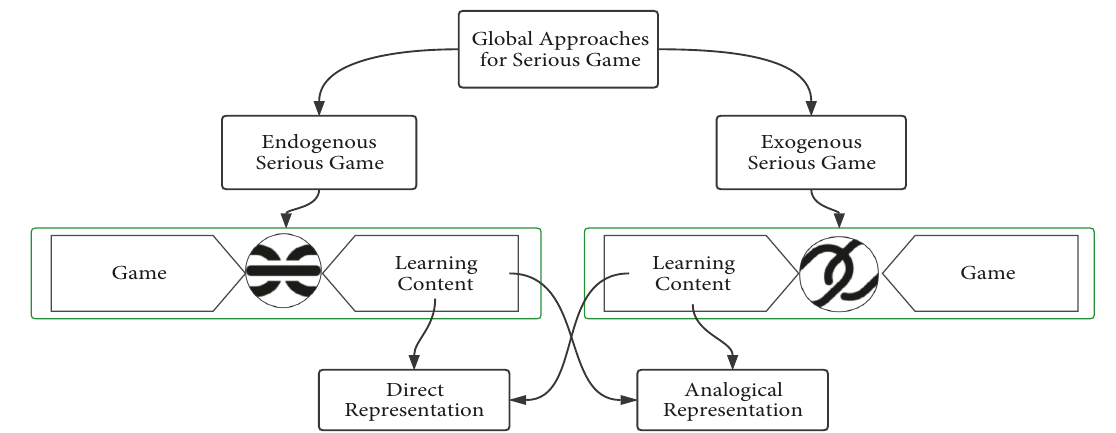
Figure 2: The hierarchical classification of serious